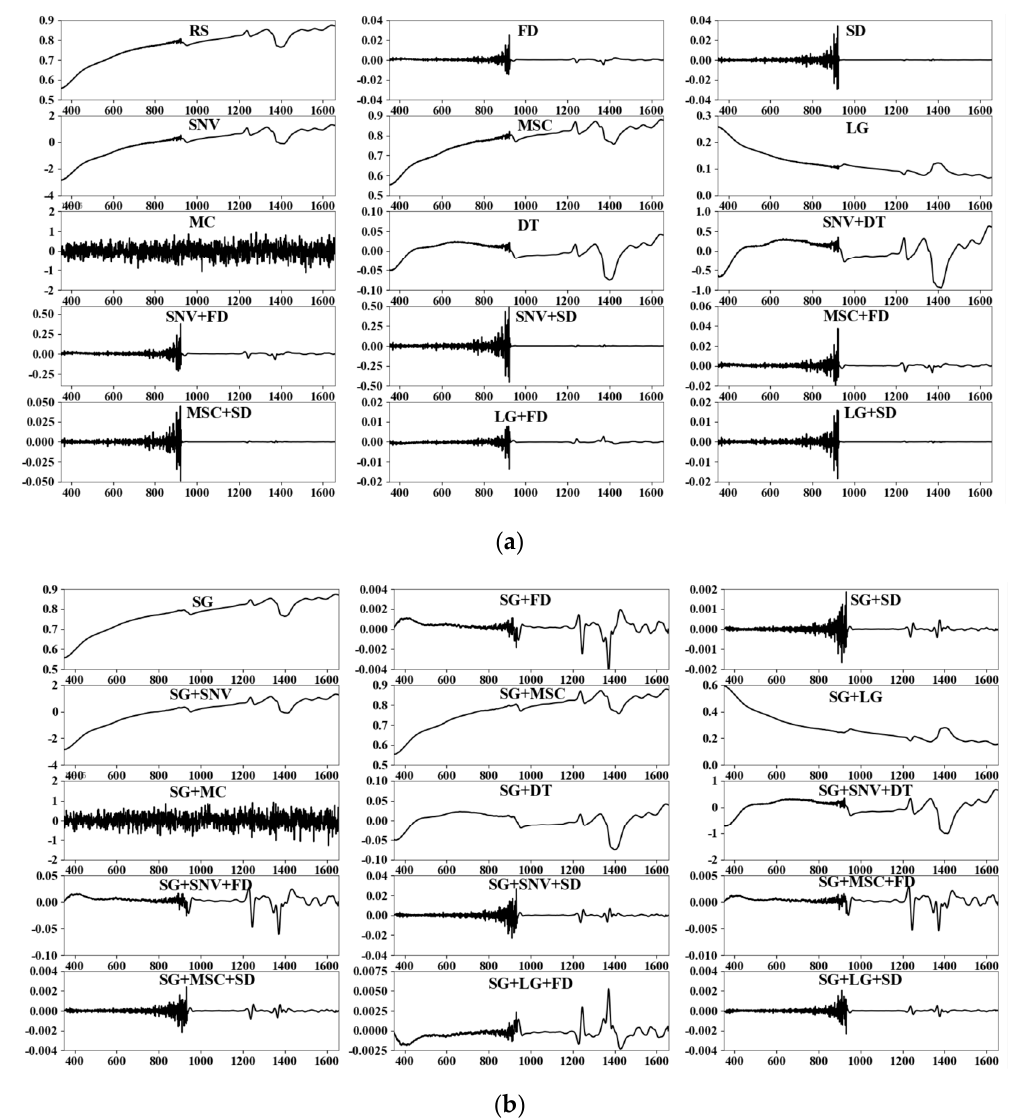
Figure 3. Average spectral contrast map of di ff erent pretreatment transformations. ( a ) Average spectrum without the Savitzky–Golay(SG) method; ( b ) average spectrum with the SG